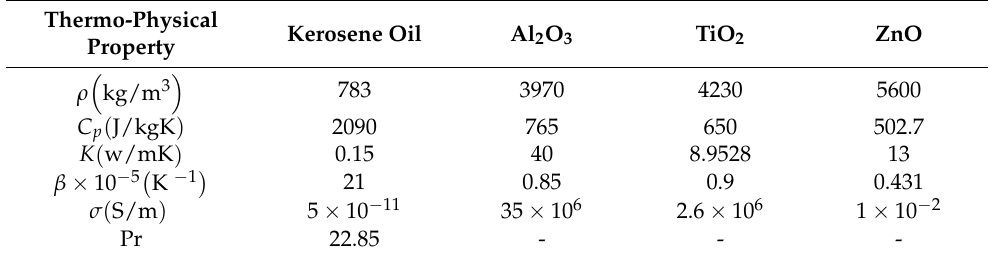
Table 1. Thermo-physical properties of Kerosene oil and nanoparticles [14,29,45,84].